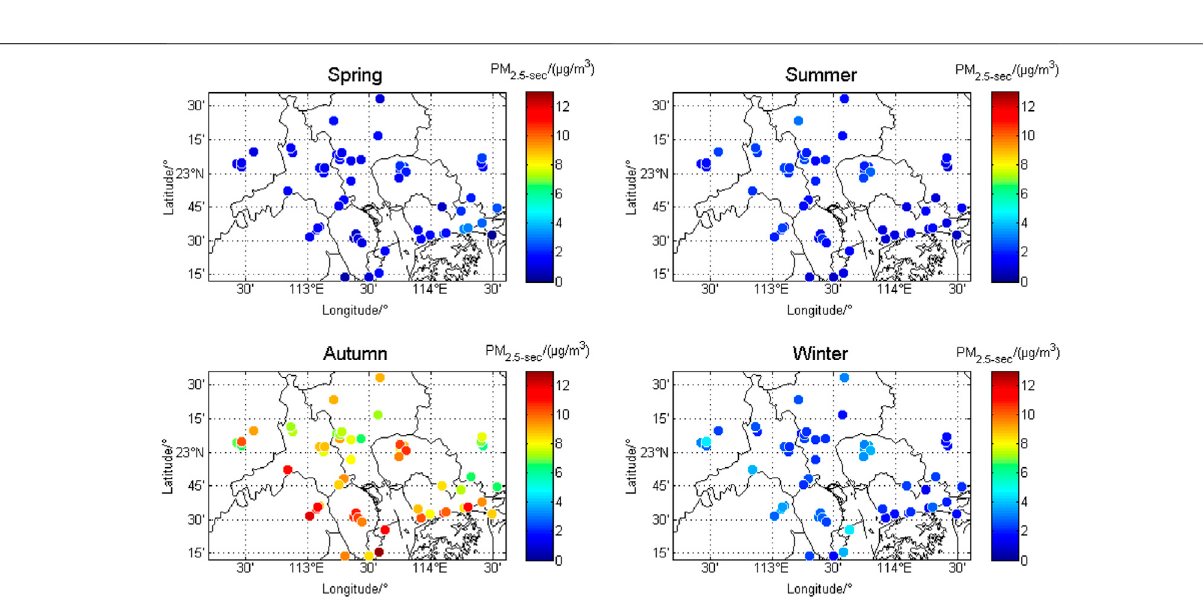
Frontiers in Environmental Science |